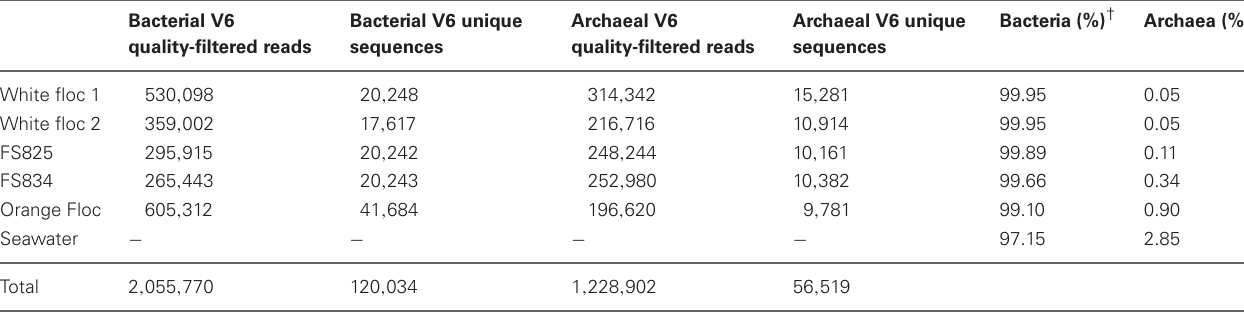
Table 3 | Summary of Illumina sequencing and qPCR results for each